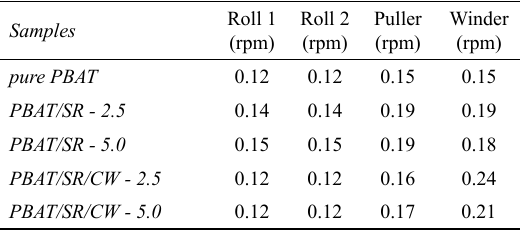
Table 3. Speed of the cooling rollers, puller and winder.